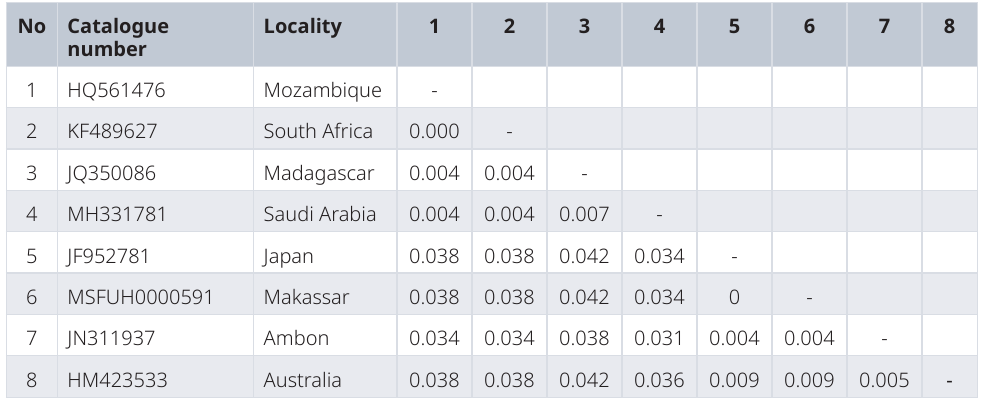
Table 2. Genetic distance between L. harak populations based on the compute within groups mean distance method.